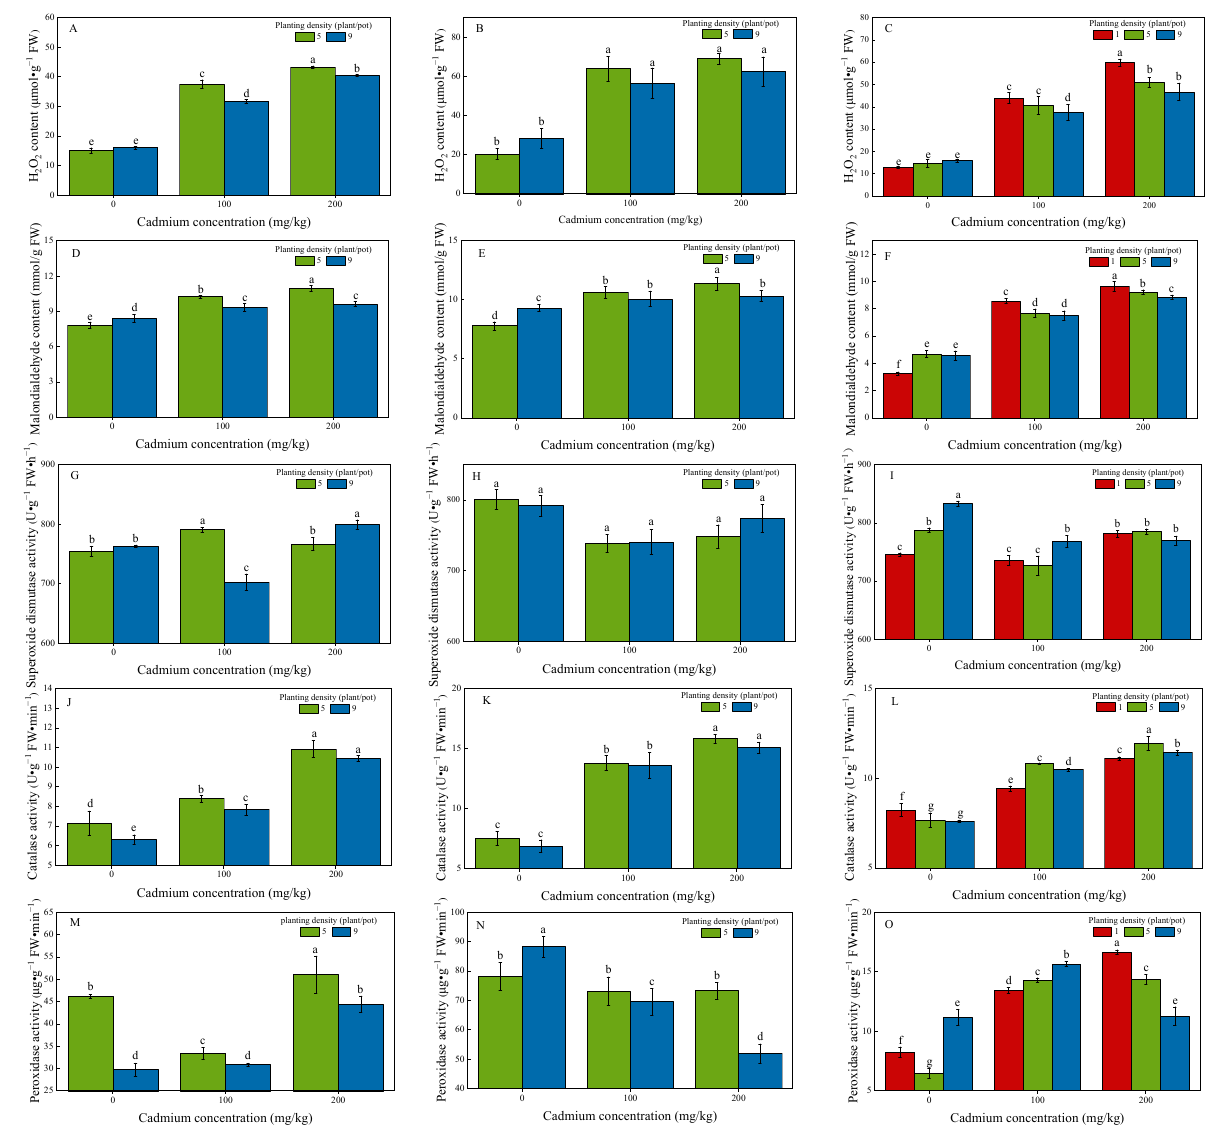
Figure 4. Enzyme activity, including H 2 O 2 content, MAD content, SOD activity, CAT activity, and POD activity, of A. philoxeroides and T. regens subjected to cadmium concentration and planting density. ( A , D , G , J , M ), ( B , E , H , K , N ), and ( C , F , I , L , O ) were the enzyme activity of A. philoxeroides in mixed culture, the enzyme activity of T. regens in mixed culture, and the enzyme activity of A. philoxeroides in monoculture, respectively. Lowercase letters indicate a significant difference ( p < 0.05) in A. philoxeroides or T. regens present on each treatment based on post hoc multiple comparisons in Duncan with cadmium concentration and planting density as fixed factors.